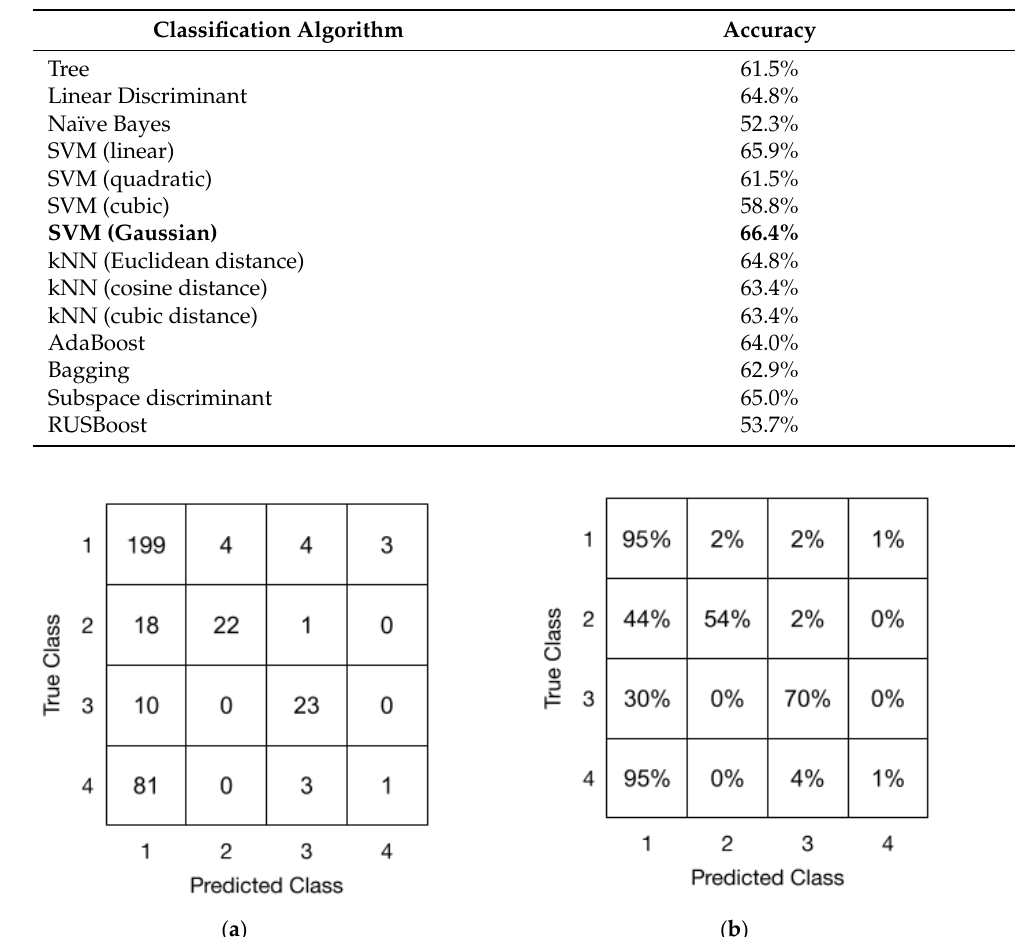
Table 1. Results of the accuracy performance assessment of various classification algorithms with the 369 occurrences.